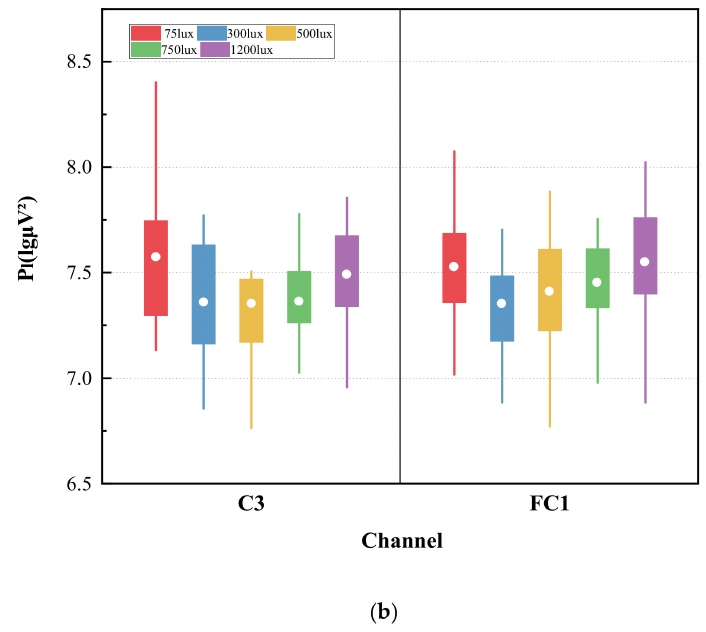
Figure 13. P l of each channel: ( a ) δ band and ( b ) β band.